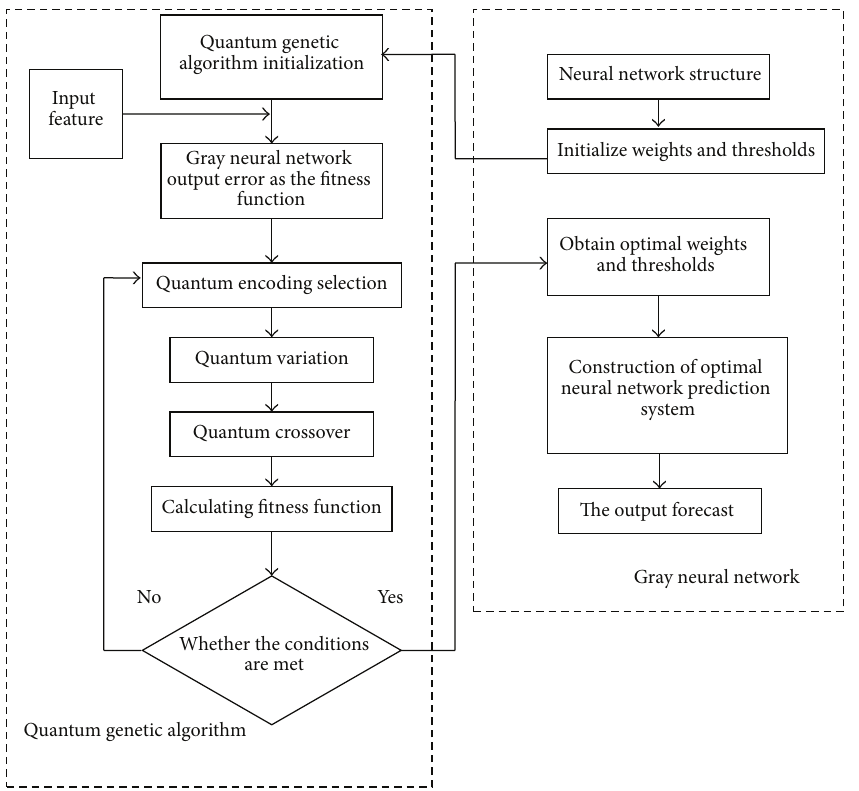
Figure 6: Construction flow of the forecasting model.